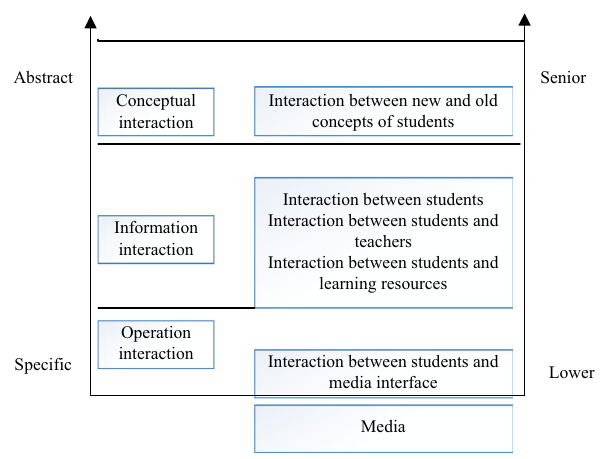
Fig. 1 Hierarchical tower model of teaching interaction